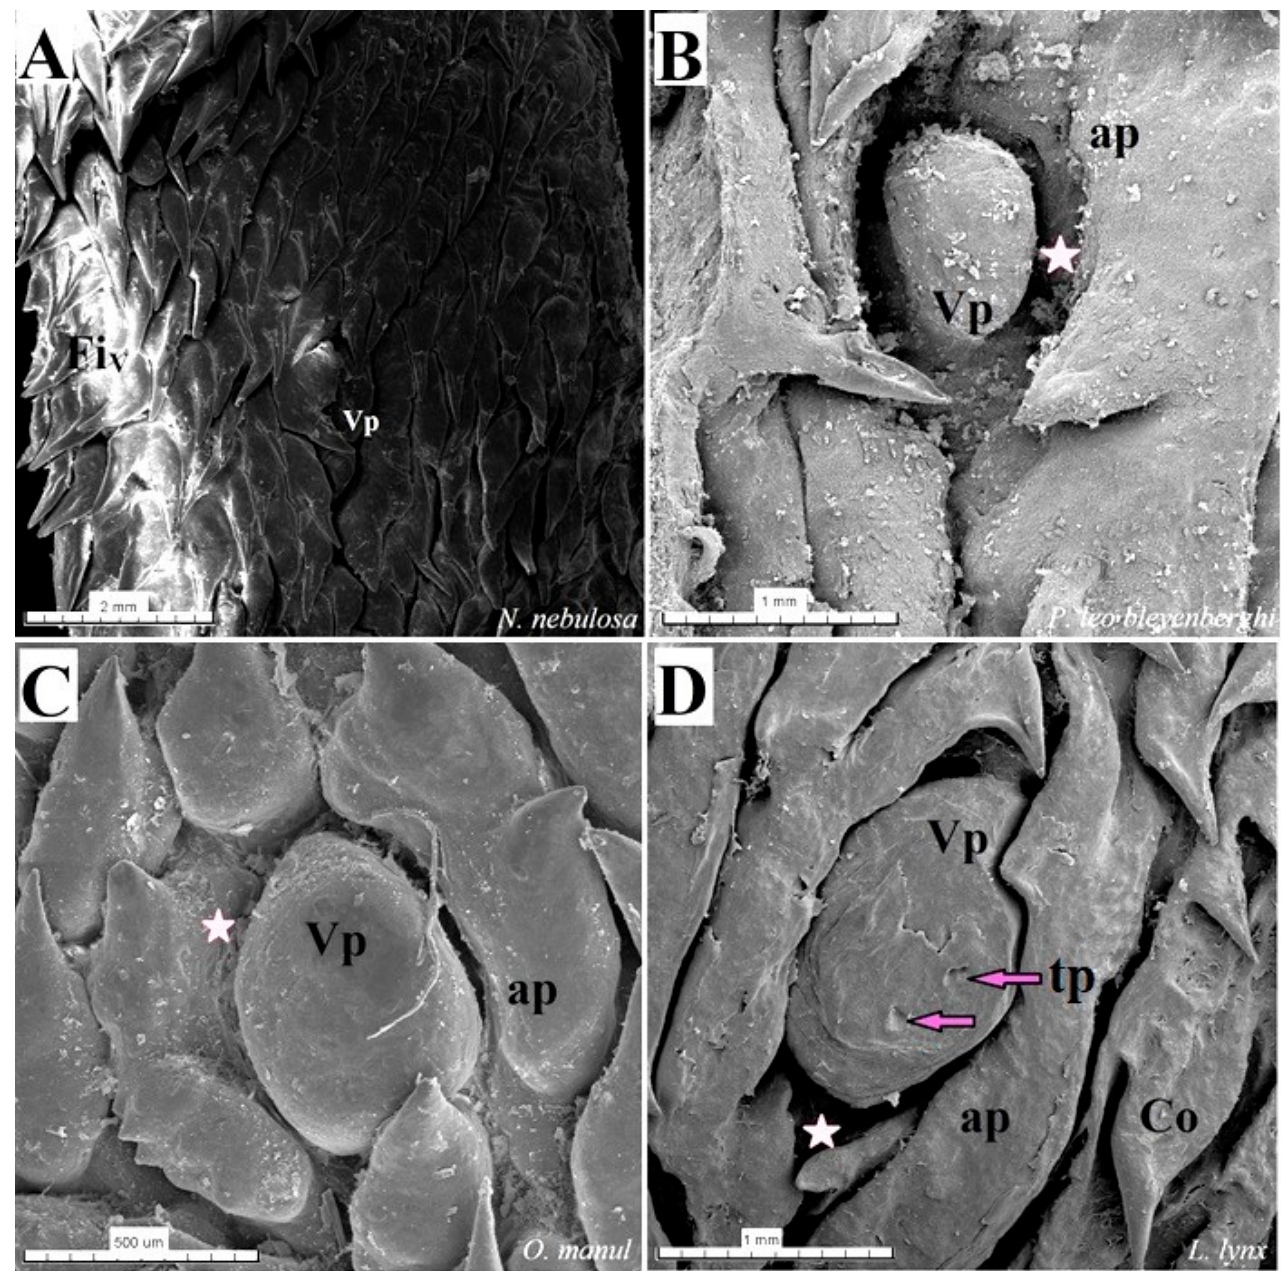
Figure 18. Scanning electron microscopic (SEM) pictures of the vallate papillae of the tongue of the four species of undomesticated Felidae: N. nebulosa ( A ), P. leo bleyenberghi ( B ), O. manul ( C ) and L. lynx ( D ). ( A ) An elongated-shaped vallate papilla. ( B ) Well-visible deep papillary groove and oval- shaped vallate papilla. ( C ) Vallate papillae encircled by an irregular annular pad. ( D ) Two taste pores on the dorsal surface of the vallate papilla. Bar = 2 mm (A); bar = 1 mm (B,D); bar = 500 (C). Abbreviations: ap—annular pad with irregular surface with exfoliated cells, Co—conical papilla, tp—taste pore of the taste bud (purple arrow), Vp—vallate papilla, * (asterisk)—groove of the vallate papilla .